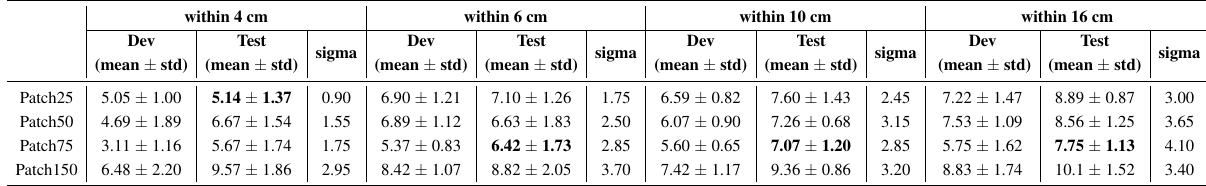
Table A8. HTERs (%) of GLOH features (no overlap, PCA 90%).